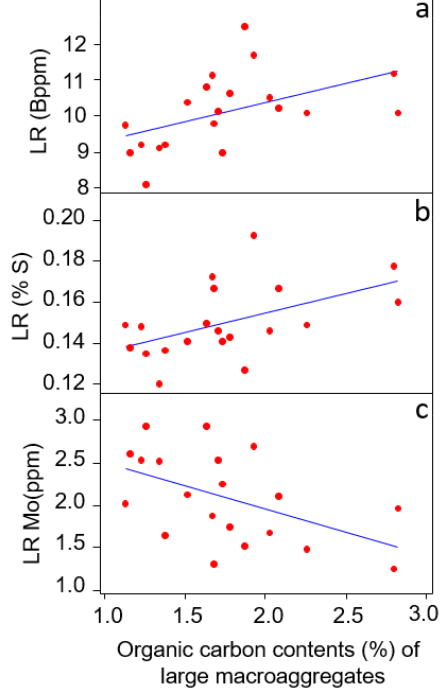
Figure 3. The relationship between the organic carbon contents (%OC) of soil large macroaggregates with the B ( a ), S ( b ), and Mo ( c ) contents of LR, as determined by the linear regression. Only significant ( p < 0.05 ) relationships are plotted.